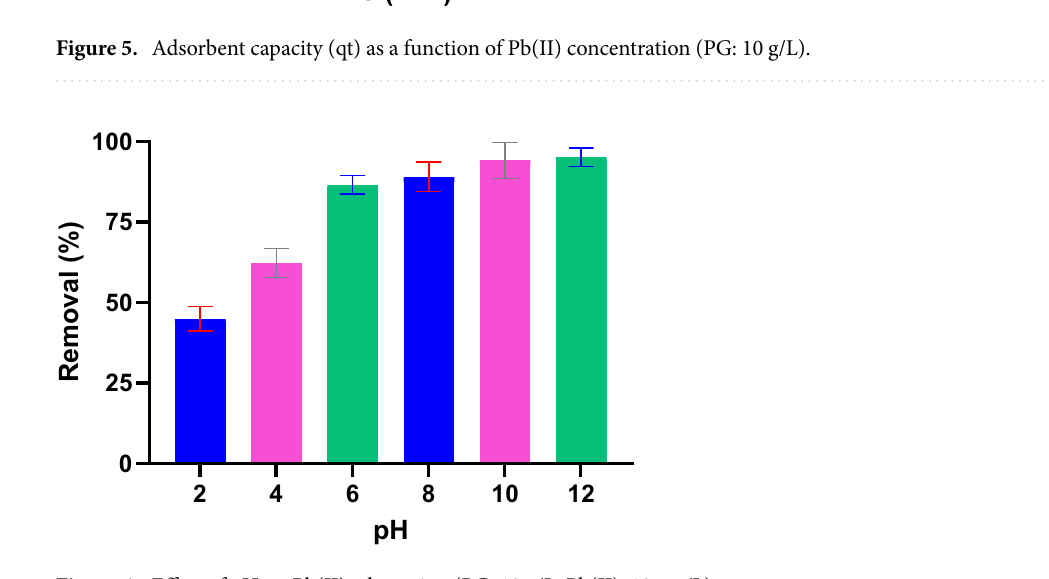
Figure 6. Effect of pH on Pb(II) adsorption (PG: 10 g/L, Pb(II): 10